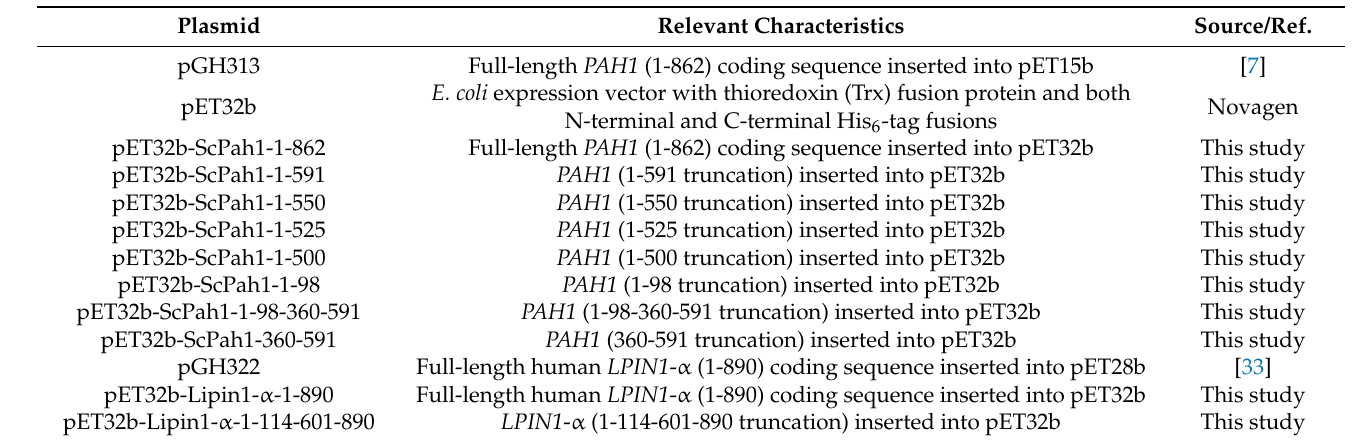
Table 1. List of plasmids used in this study.